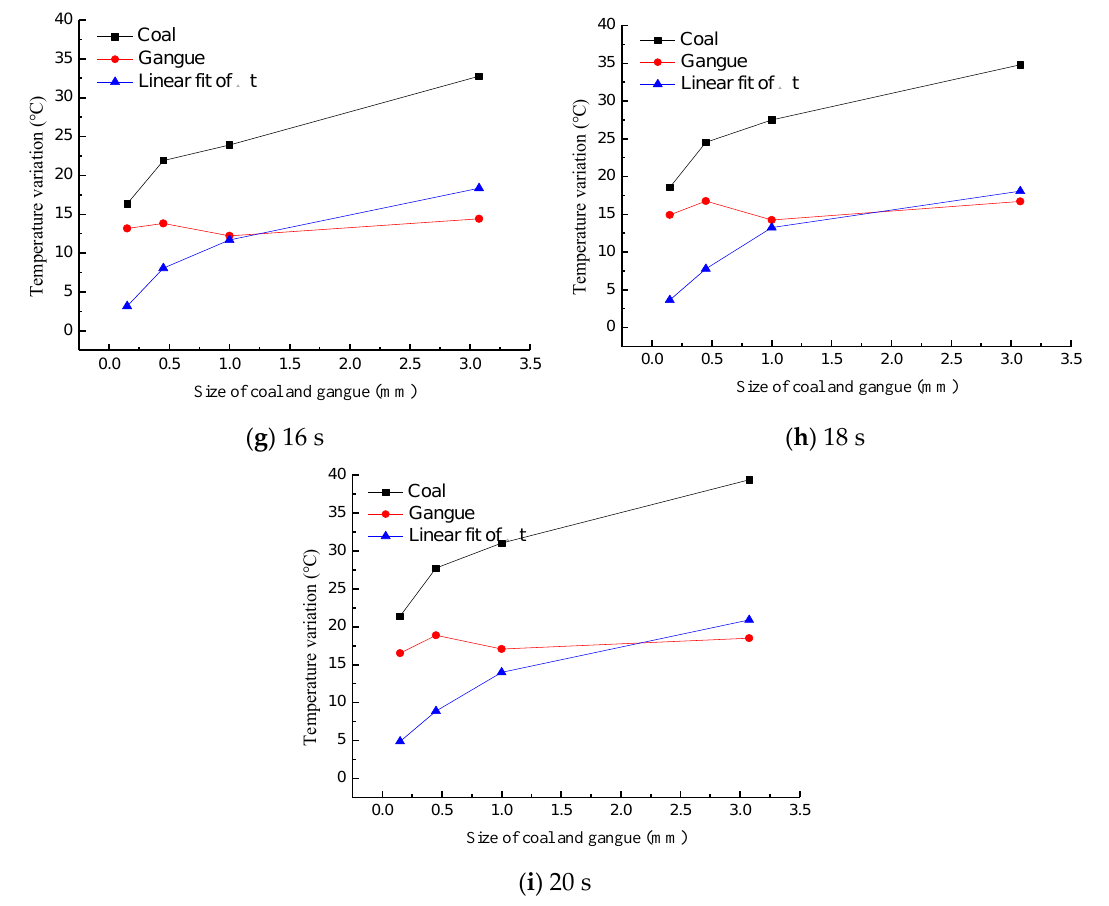
Figure 21. Microwave thermosensitive test results of different coal and gangue sample size under different microwave irradiation time. different microwave irradiation